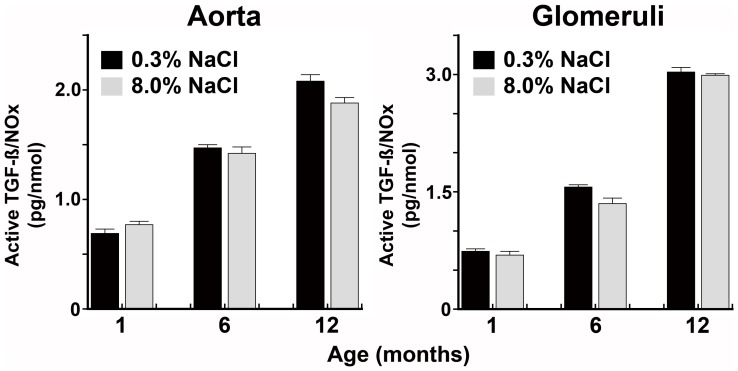
The production of active TGF-ß relative to NOx progressively increases with age.Least square means comparison demonstrated a strongly significant linear effect for increasing active TGFß/NO (pg/nmol) with age for both aortic rings and isolated glomeruli (all p-values<0.0001).